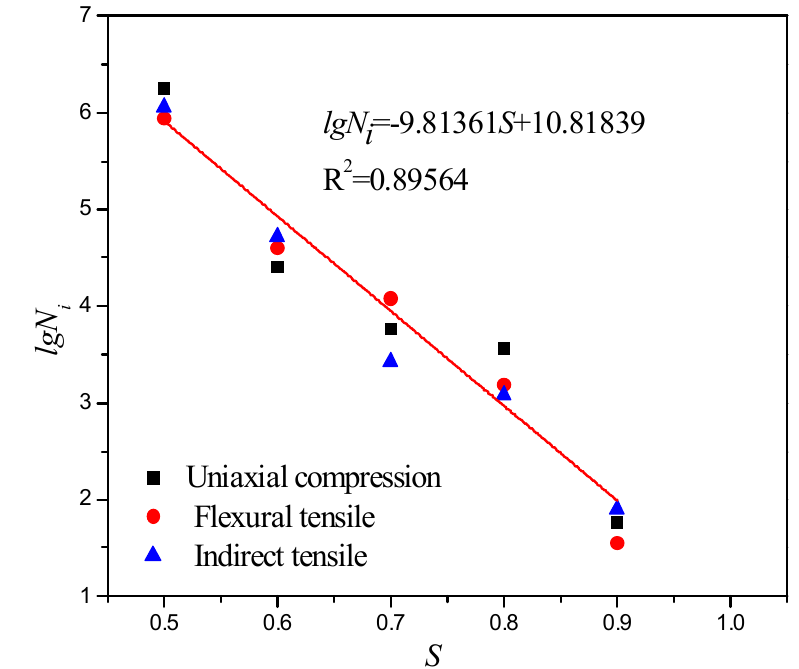
Figure 13. Standardization equations for fatigue properties with a cement content of 4% at a curing time of 90 days and a guaranteed rate of 95% under different stress states.